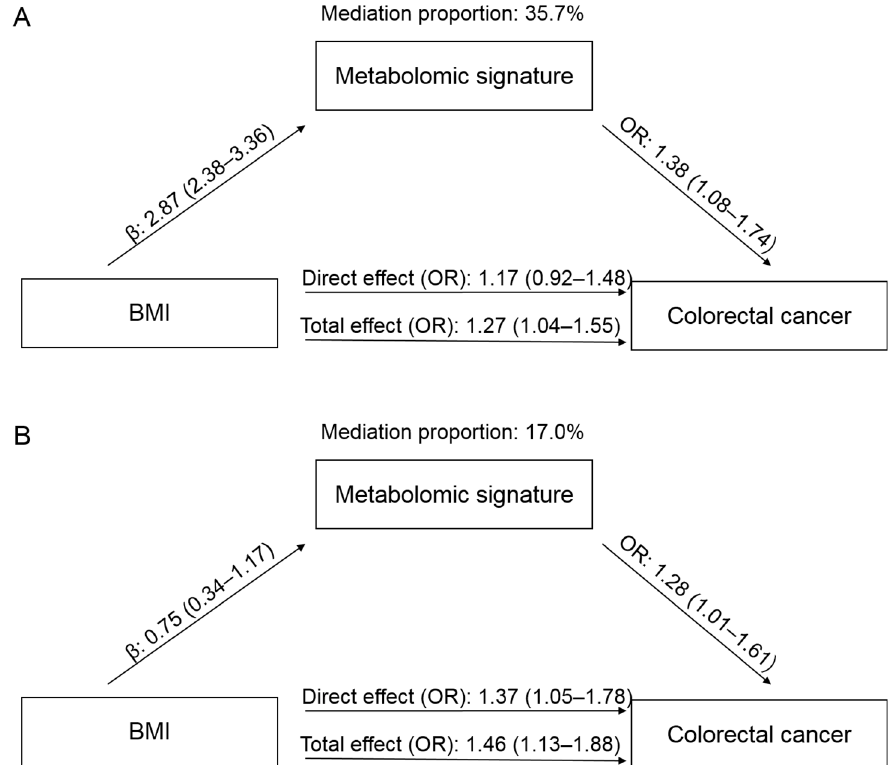
Figure 3. Mediation effects of the metabolomic signature on the association between body mass index (BMI) and colorectal cancer (CRC) in the PLCO ( A ) and Jiangsu ( B ) cohorts. The total effect represents the association between BMI and CRC without adjustment for metabolomic signature, while the direct effect shows the association after adjustment for metabolomic signature. Abbreviations: PLCO, Prostate, Lung, Colorectal, and Ovarian Cancer Screening Trial; OR, odds ratio.